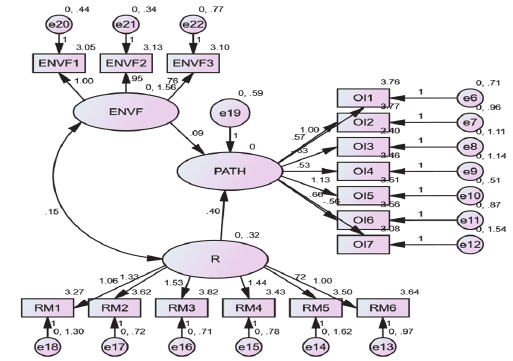
Fig. 6. Structural model of environment factors, pathway for entrepreneurs and research